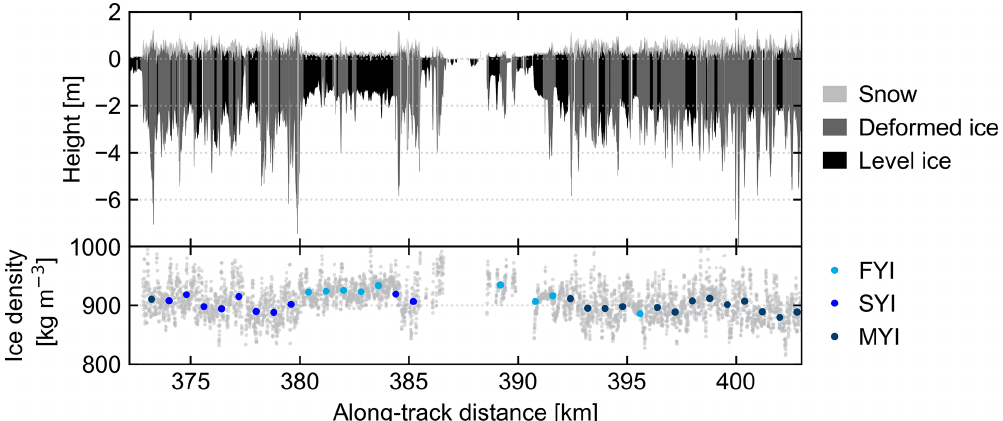
Figure 5. Approximately 30km along-track profile during the survey over the Beaufort Sea on 7 April 2019. The upper panel shows the snow and ice layers, of which the latter is split into deformed and level ice sections, derived from the total thickness, snow freeboard, and snow depth measurements in the native 5–6m point spacing. The zero height refers to the local sea-surface height. The corresponding calculated sea-ice bulk density values are represented by grey dots in the lower panel together with the 800m along-track averages that are coded according to the sea-ice type with colour.